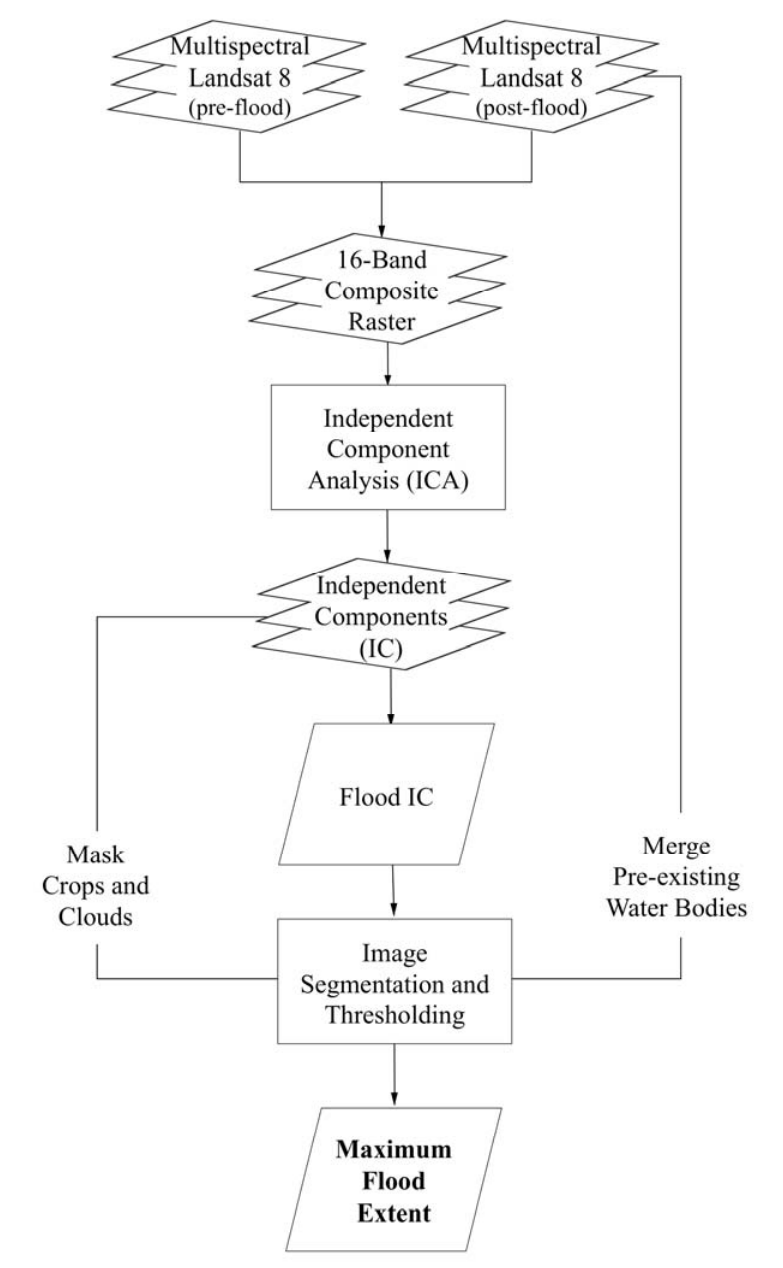
Figure 2. Workflow of the flood mapping